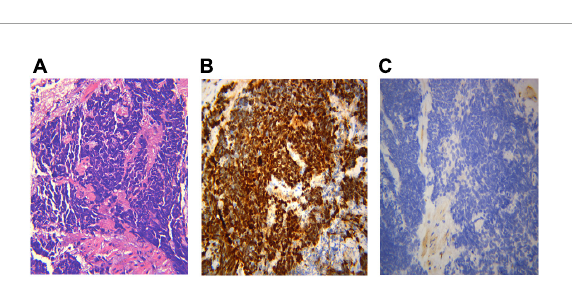
FIGURE7 Histological biopsy of a case of small cell lung cancer (SCLC). HE staining presents the morphological features: tumor cells are small in size and round or oval in shape, mimicking lymphocytes, with rare cytoplasm, deeply stained nuclei and invisible nucleoli ( A , HE 400 × ). Abnormal cells are positive for TTF-1 immunoreactivity ( B , IHC 400 × ), and negative for CD56